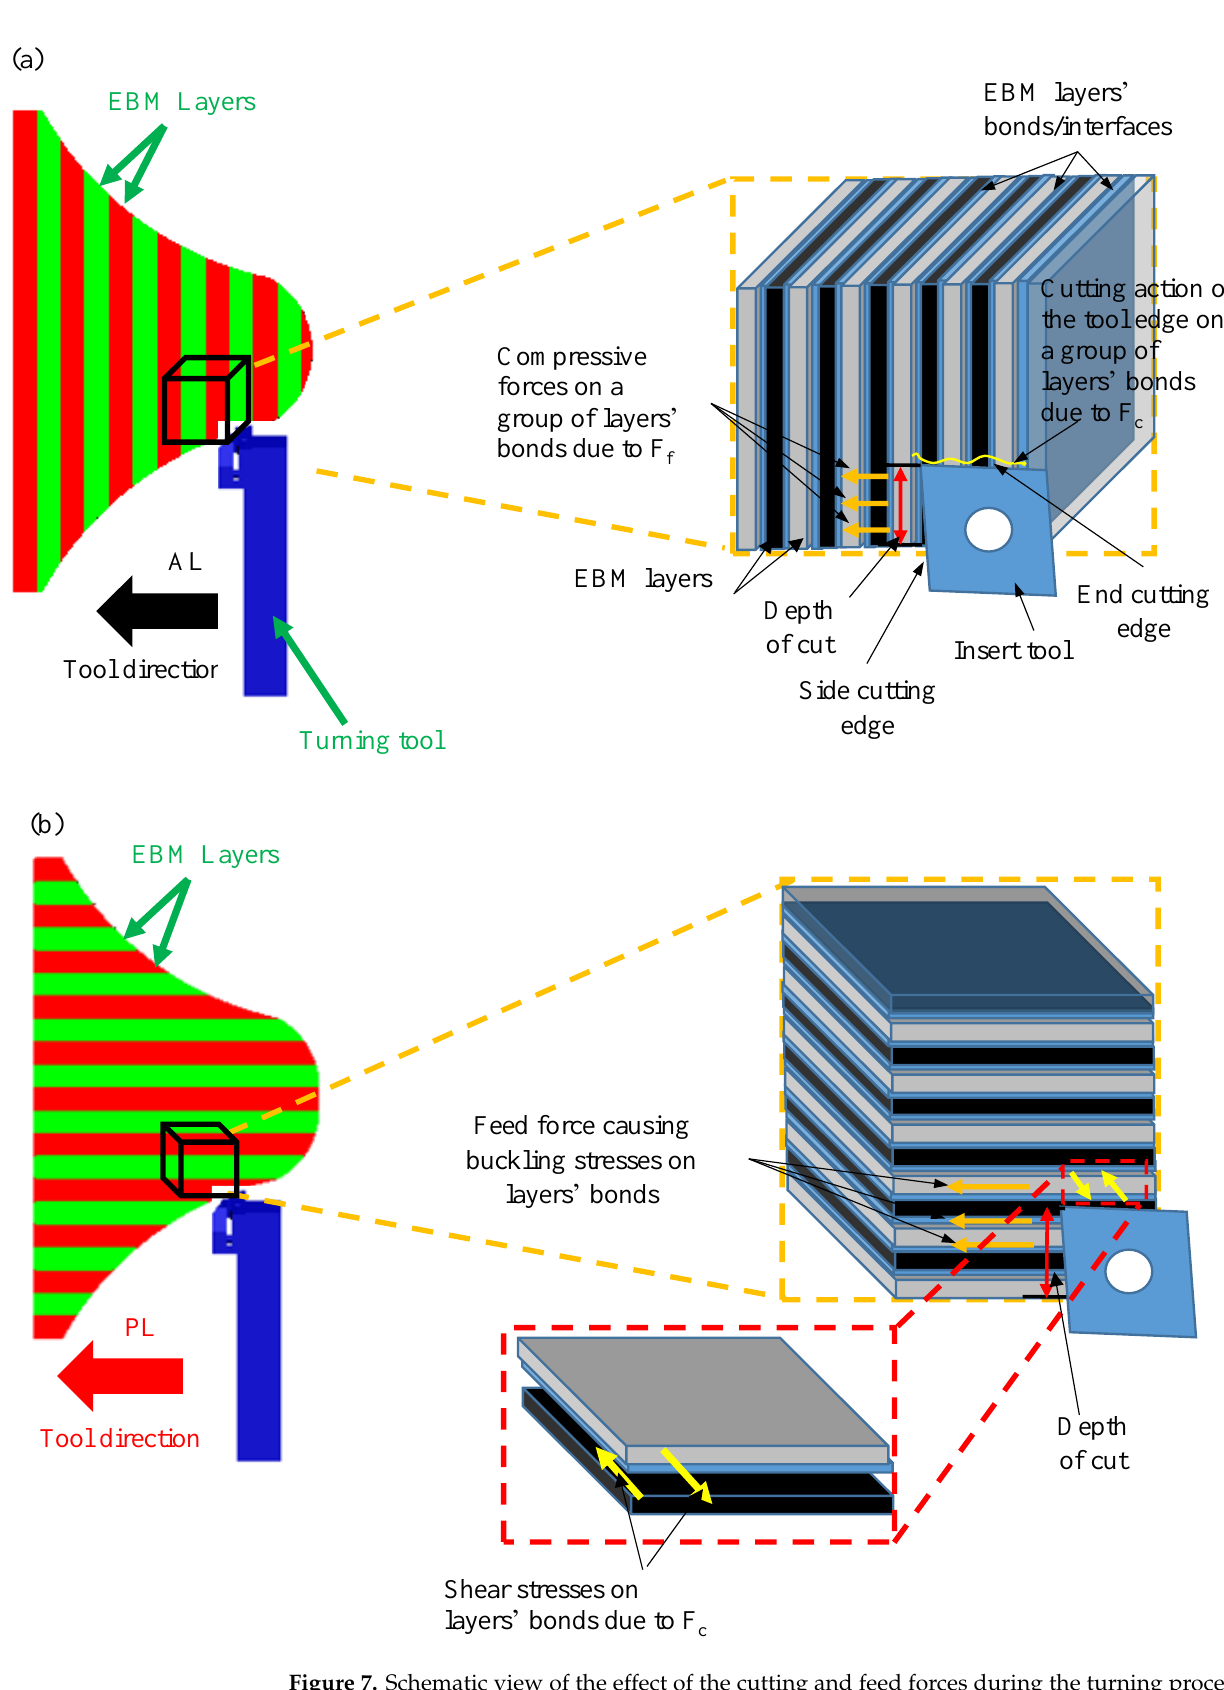
Figure 6. Two-dimensional roughness profiles at V = 30 m/min and f = 0.1 mm/rev for ( a ) AL orien- tations and ( b ) PL orientations.